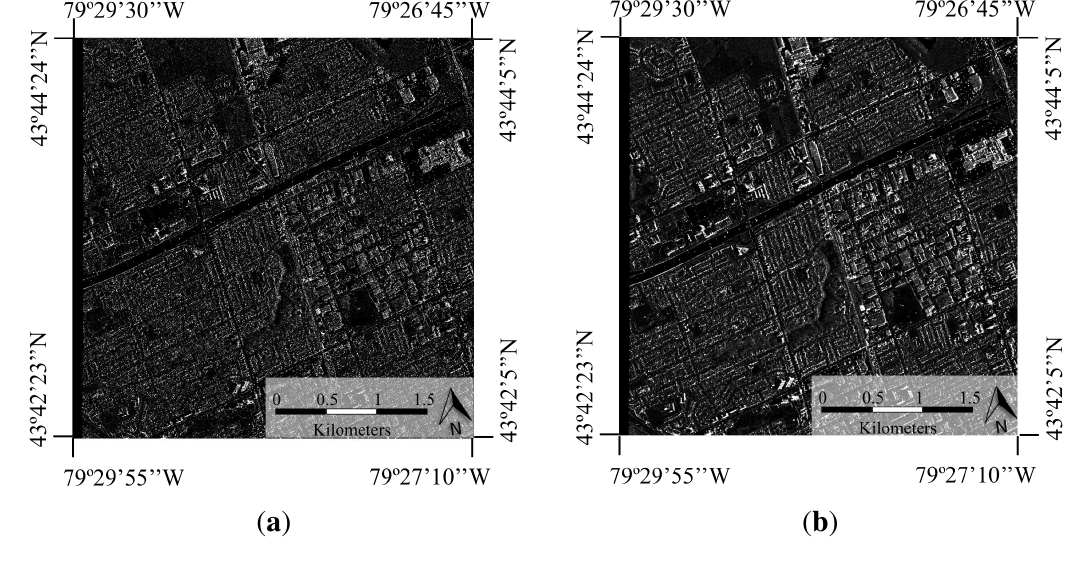
Figure 1. Comparison between spatially enhanced (SE) and radiometrically enhanced (RE) products. ( a ) SAR image of Toronto with SE geometric resolution; ( b ) SAR image of Toronto with RE geometric